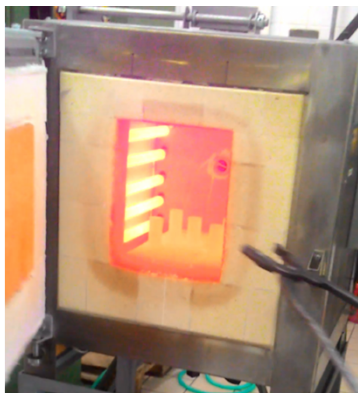
Figure 2. Heat treatment in a furnace